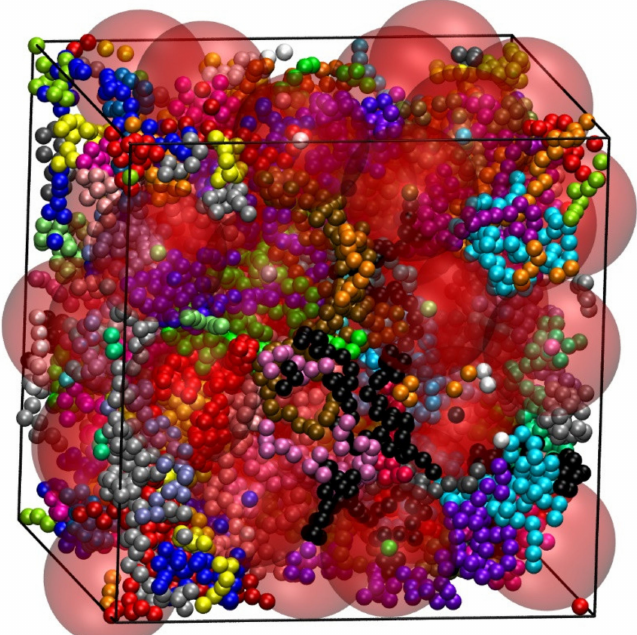
Figure 15. Terminally grafted nanoparticles on polymer chains at a volume fraction of ϕ = 0.50 as simulated through the Simu-D suite. Each nanoparticle, shown in red and in semitransparent format, has a size of d nano = 8 and is anchored to a single polymer chain. Macromolecules are represented as freely jointed chains of tangent hard spheres with an average length of N =